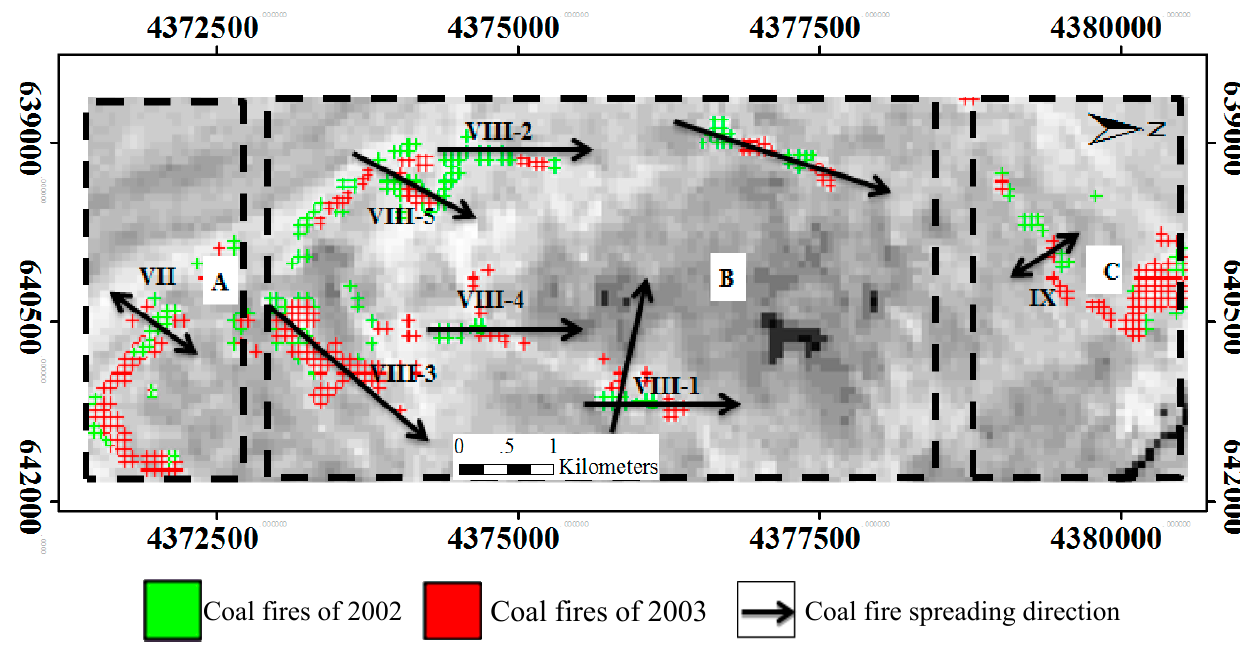
Figure 12. Coal fire map from 2002 to 2003. The results of the coal fires of 2002 and 2003 were stacked for the overlay analysis, and the coal fire spreading directions were also delineated as shown in this